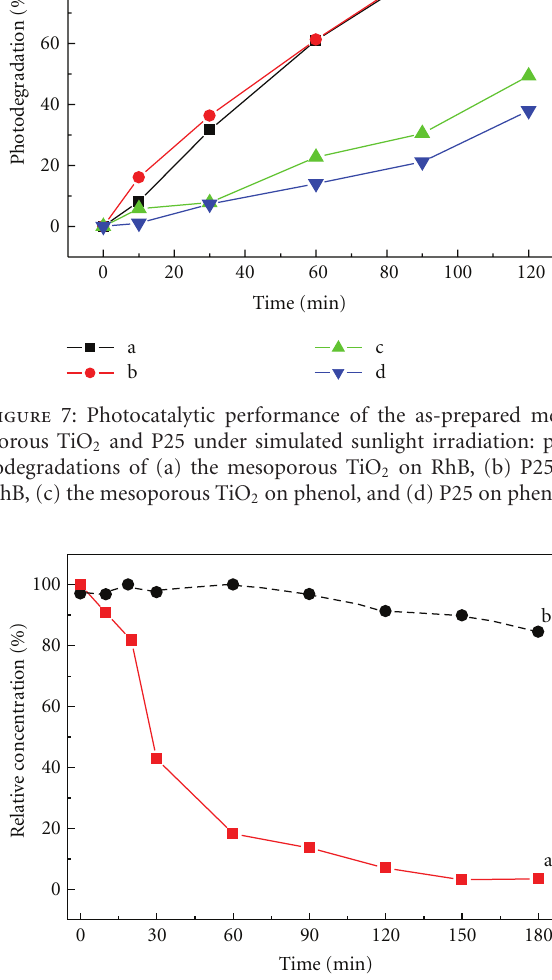
Figure 8: Photodegradation preference of the as-prepared TiO 2 on RhB and phenol in their mixture solution under simulated sunlight: (a) RhB, (b)